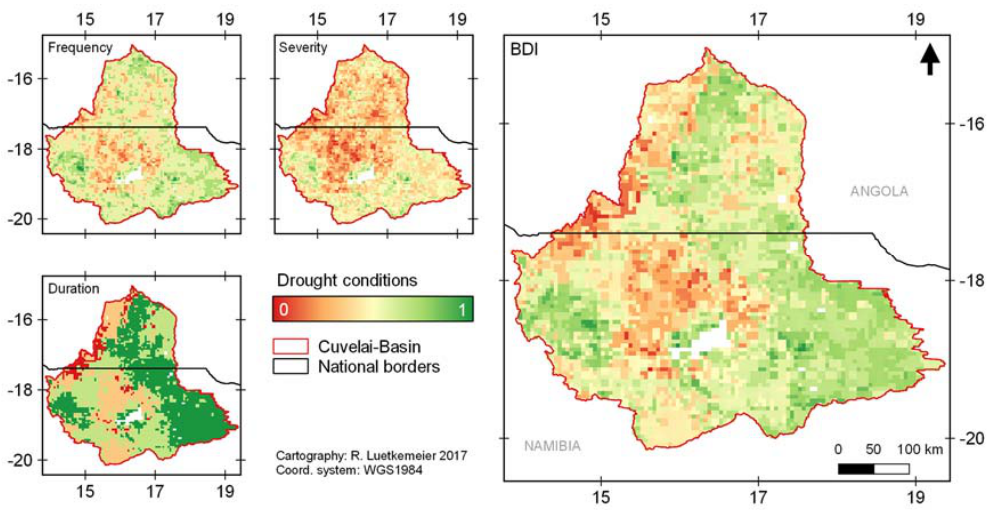
Figure 5. Spatial representation of the copula, for the Cuvelai-Basin. Beside frequency of occurrence, severity and duration, the BDI itself is presented as the average of the individual dimensions on a pixel-basis.